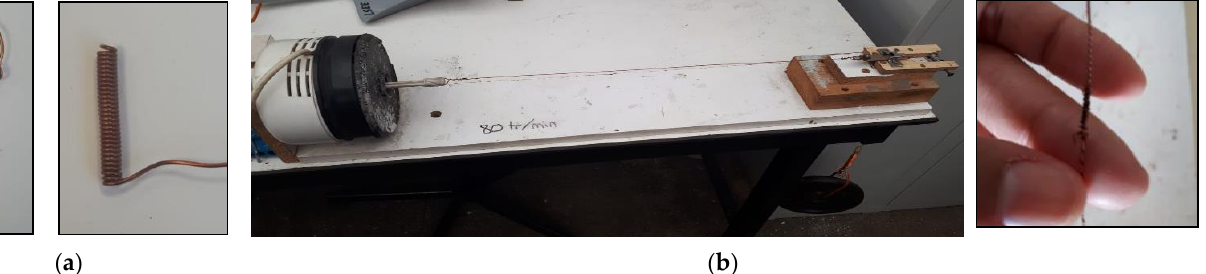
Figure 4. Mechanical tests. ( a ) Flexibility tests samples. ( b ) Peel test device.